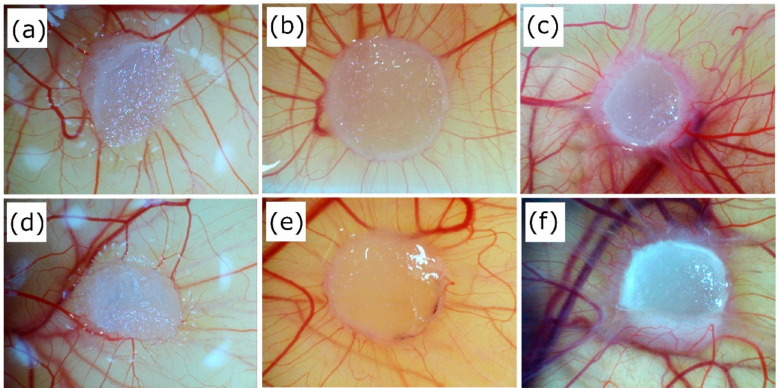
Figure 13. Coll/Chit ( a – c ) and Coll/Chit_0.1FGF2 ( d – f ) samples implanted on CAM at day 7 ( a , d ), 10 ( b , e ) and 13 ( c , f ). No significant differences were found.